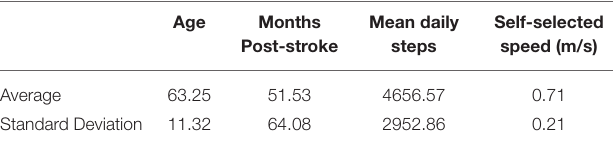
TABLE 1 | Overall demographics for all subjects ( n = 142).